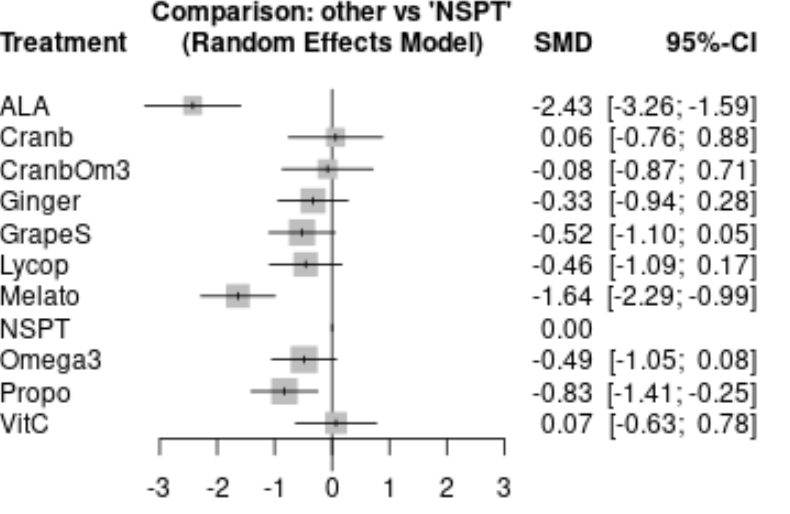
Figure 5. Forest plot showing the performance of different antioxidants used as adjuncts to NSPT, compared to NSPT